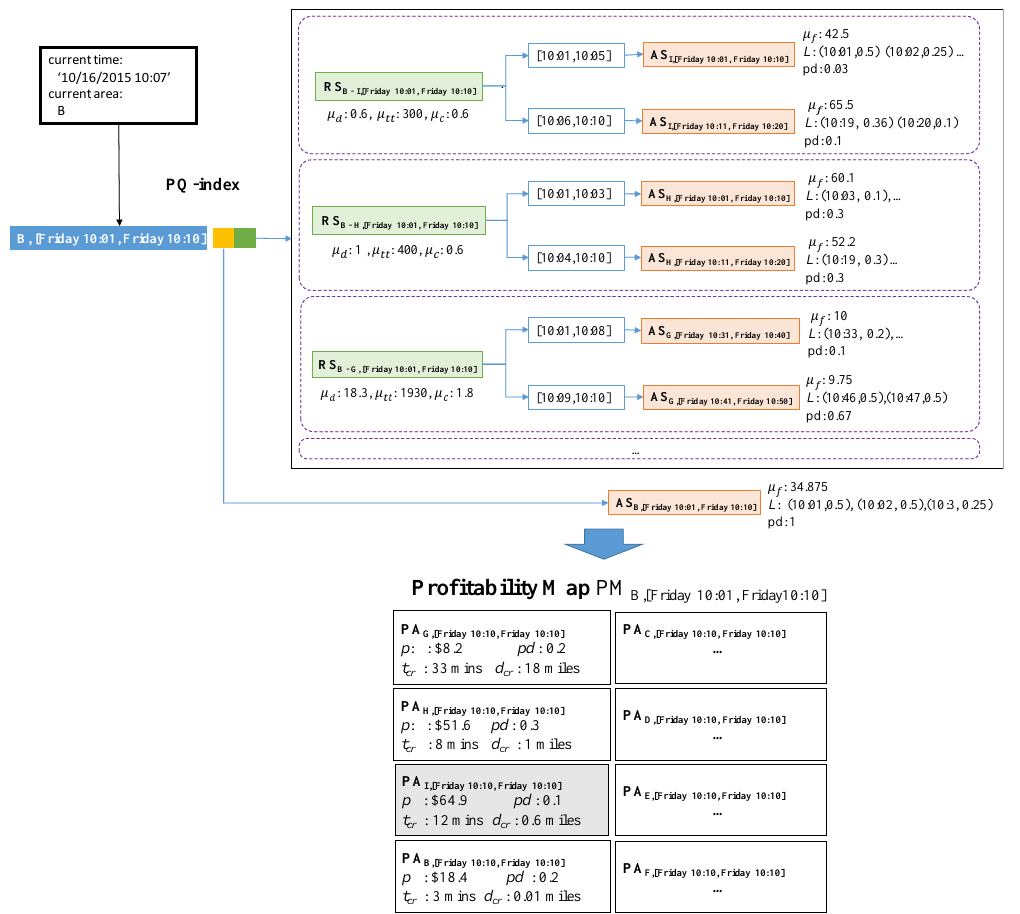
Figure 17. How to retrieve a profitability